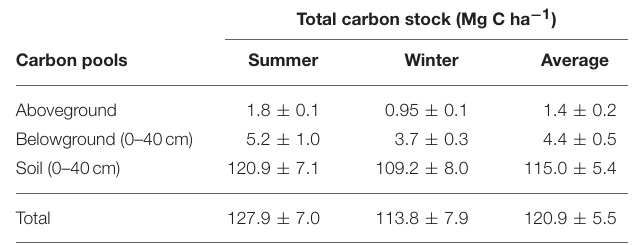
TABLE 4 | Average ± SE of the carbon stock (Mg ha − 1 ) in pasture under Voisin’s Rational Grazing for carbon pools and the total carbon stock in summer and winter ( n =